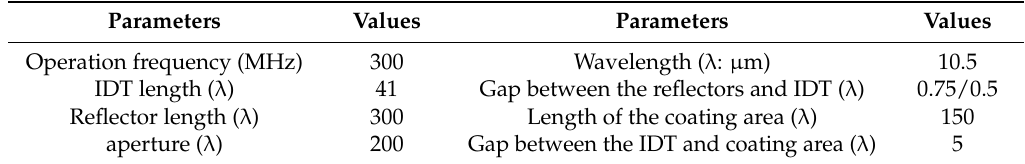
Table 1. Design parameters for the SAW sensor chip.